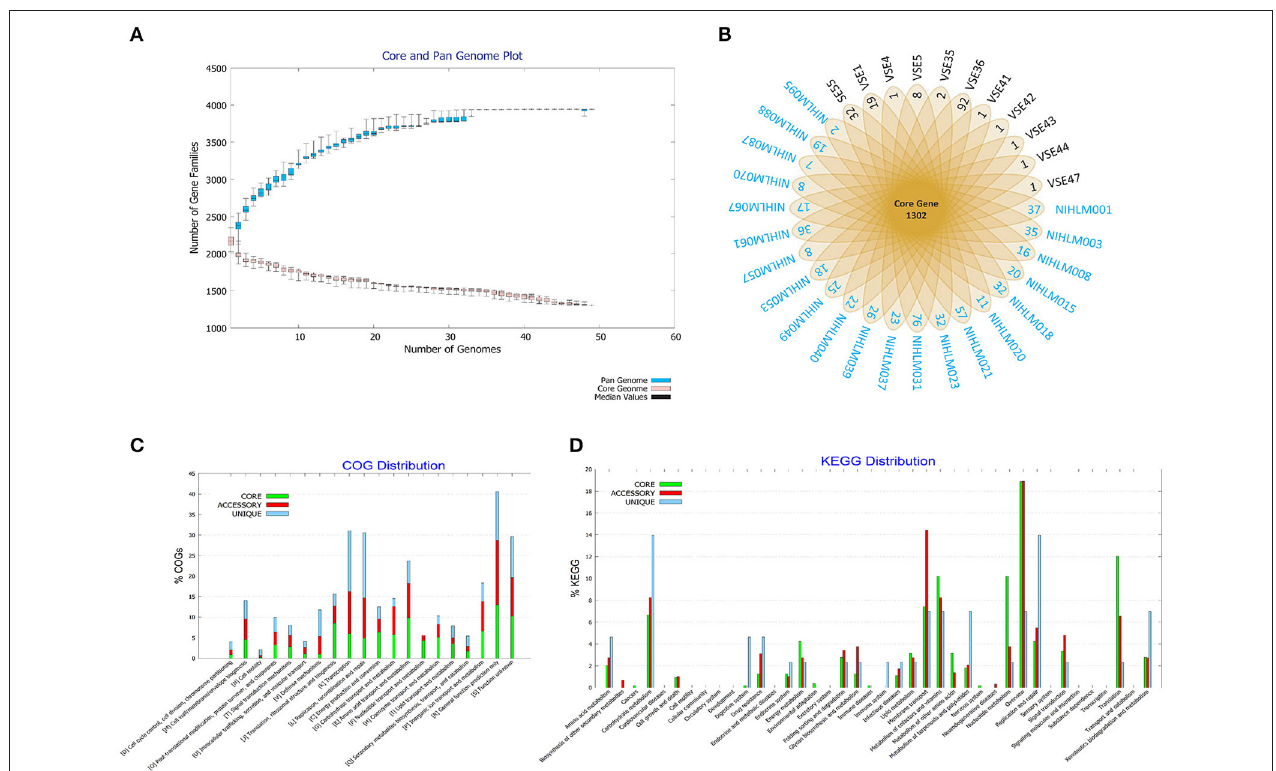
FIGURE 4 | Pangenome profile analysis of 49 S. epidermidis isolates. Indian origin isolates are highlighted in black, while American origin isolates are marked in blue (A) Pan-genome curve generated by plotting total number of gene families in the pan and core genome for all isolates. (B) Polar diagram showing isolates having unique number of genes. 32 isolates out of 49 possess unique genes, represented in outer edge of the diagram. (C) Collective distribution of core, accessory and unique genes of all 49 isolates in COG and (D) KEGG